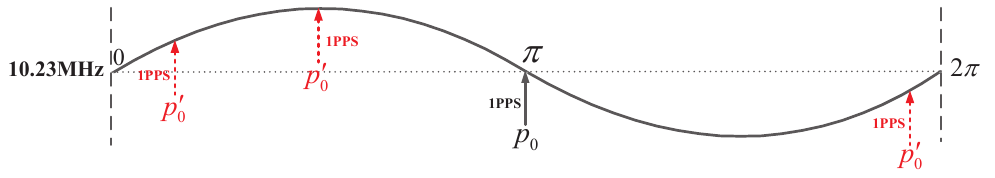
Figure 3. Uncertainty of the initial phase between the 1 PPS and the 10.23